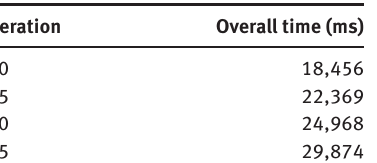
Table 4: Overall Time Measures for Our Proposed Research.